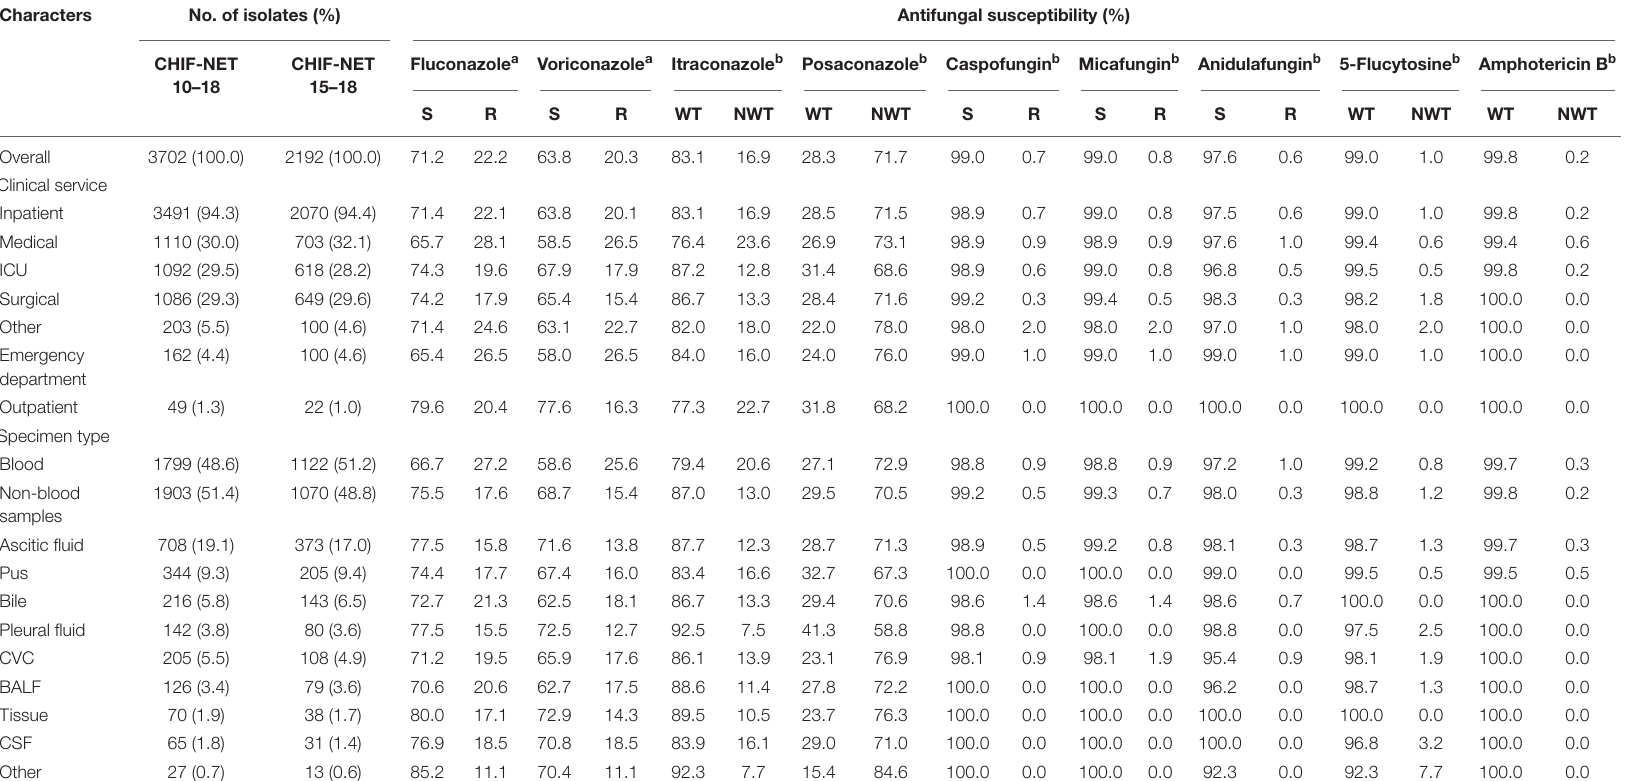
TABLE 1 | Distribution and antifungal susceptibility of C. tropicalis by clinical services and specimen types.